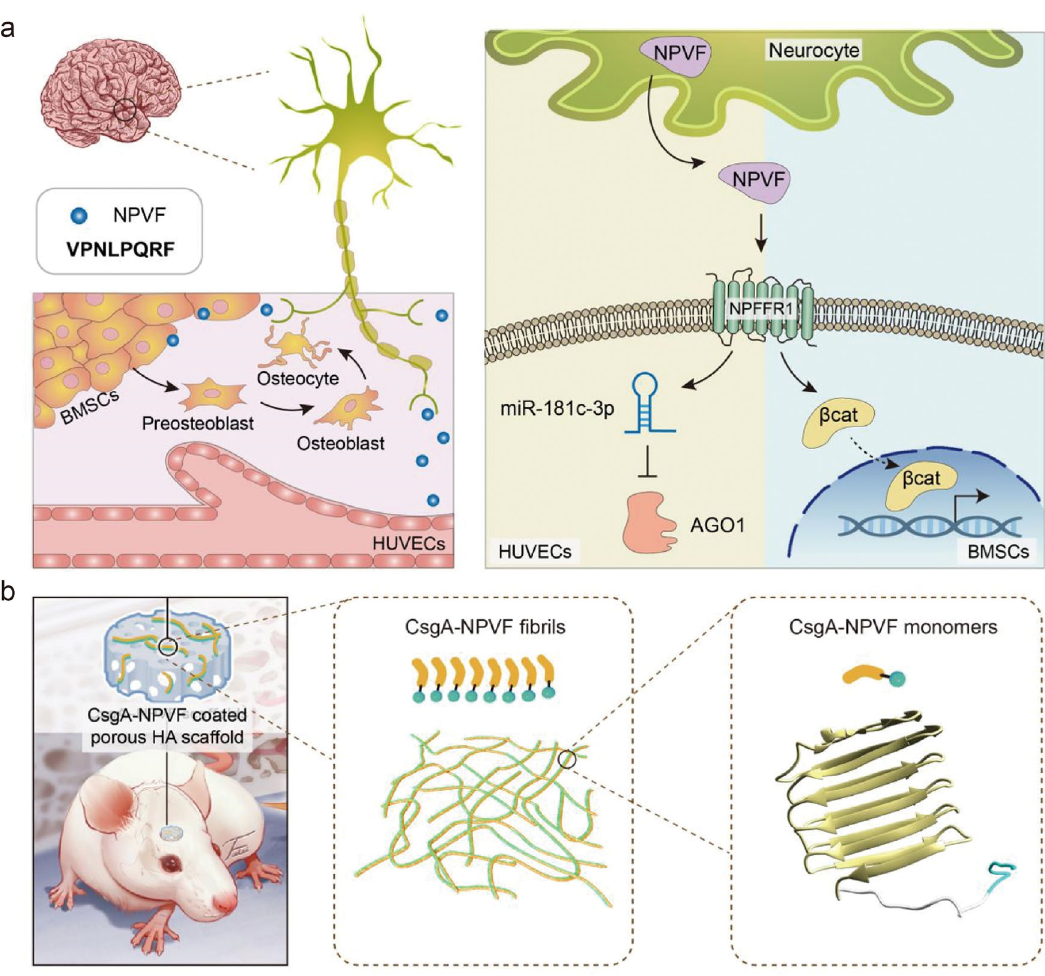
Fig. 1 Unveiling the role and mechanism of NPVF in mediating crosstalk between the brain and bone and application of self-assembling NPVF- containing protein coatings for in vivo bone defect repair. a Schematic image depicting the promoting effect of the neuropeptide NPVF on both angiogenesis and osteogenesis. NPVF is an eight-amino acid neuropeptide secreted by the human hypothalamus, and it regulates various physiological processes including bone homeostasis maintenance by activating its G i/o protein-coupled receptor located in the nervous system (left panel). The amino acid sequence of NPVF is presented in the upper box. The right panel shows the signaling pathway by which NPVF promotes osteogenic differentiation of BMSCs and vascularization of HUVECs. NPVF binds preferentially to NPFFR1 in the central nervous system, promotes angiogenesis of HUVECs via the miR-181c-3p/AGO1 pathway, and mediates osteogenic differentiation of BMSCs via the Wnt/ β -catenin signaling pathway. b Illustration of bone fracture repair through the implantation of a CsgA-NPVF nano fi ber-coated porous hydroxyapatite scaffold in a rat calvarial defect model. The CsgA amyloid can self-assemble into nano fi bers to form a robust proteinaceous coating on the surface of given substrate. Coupling the coat-forming property of CsgA with NPVF induced new bone formation. Displaying the engineered CsgA-NPVF functional nano fi bers on the HAp scaffold substantially facilitated bone regeneration. The right panel shows the simulated structure of the CsgA-NPVF monomer revealed by molecular dynamics